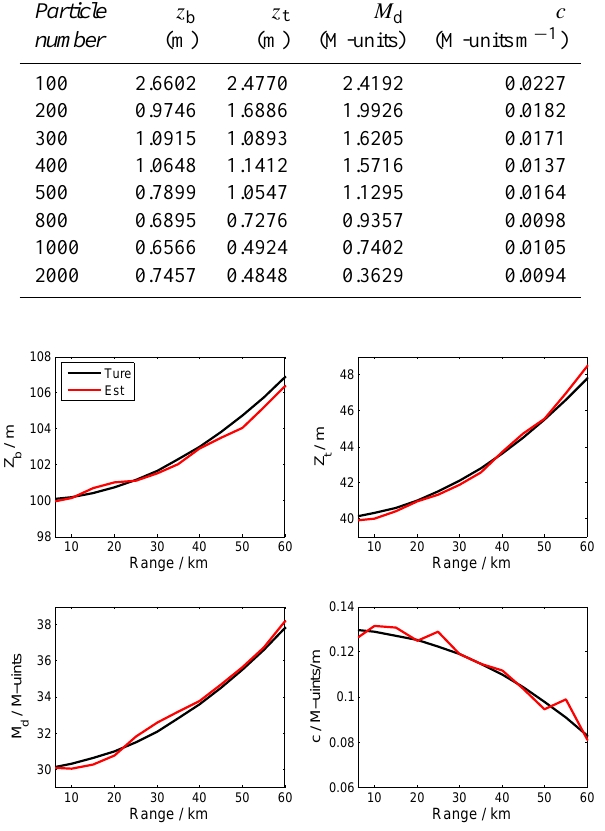
the range-varying characteristics of the refractivity within 6 km range bin are assumed to be a Gaussian random pro- cess. Owing to the duct, structures in Fig. 4 (black lines) are approximate to bilinear profiles which could be modeled by two parameters, i.e. thickness and M-deficit. Here the covari- ance for the process noise Q k and measurement noise R k are (cid:8)(cid:2) (cid:3)(cid:9) ( 10 m ) 2 ,( 10 M-units ) 2 respectively set to be Q k = diag (cid:8) (cid:9) ( 3 dB ) 2 and R k = diag . The prior distributions of thickness are randomly generated from 5 m to 80 m, and M-deficit from 5 M-units to 60